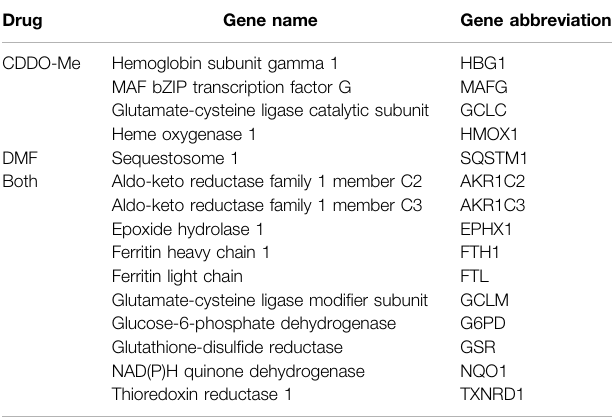
TABLE 2 | Drug speci fi c cytoprotective gene induction in K562